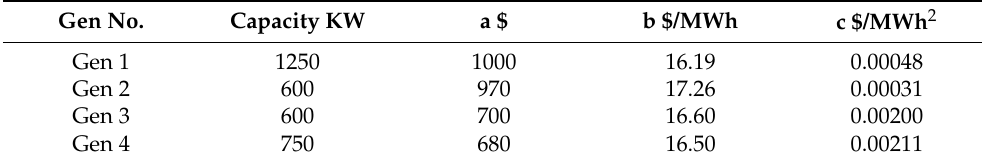
Table 1. Capacities and coefficients for each diesel